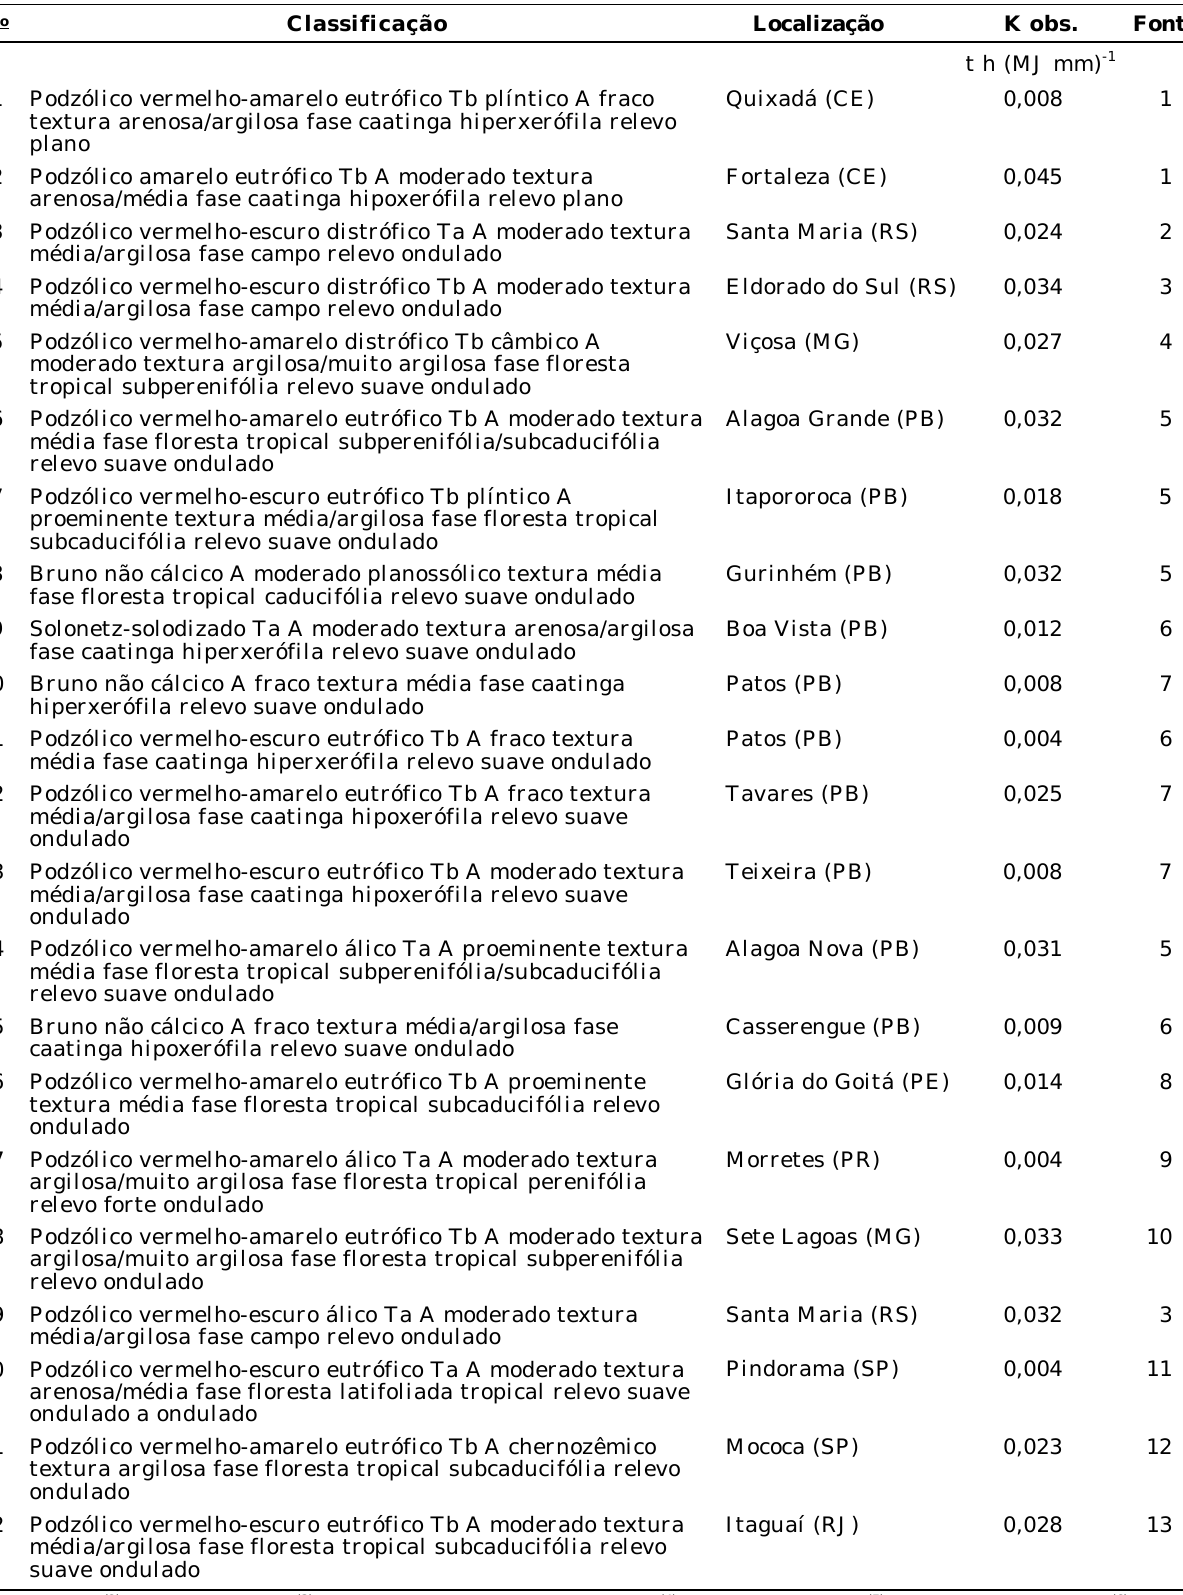
(1) Silva (1994). (2) Dal Conte (1982). (3) Levien, citado por Denardin (1990). (4) Resck et al. (1981). (5) Rodrigues do Ó (1986). (6) Silva